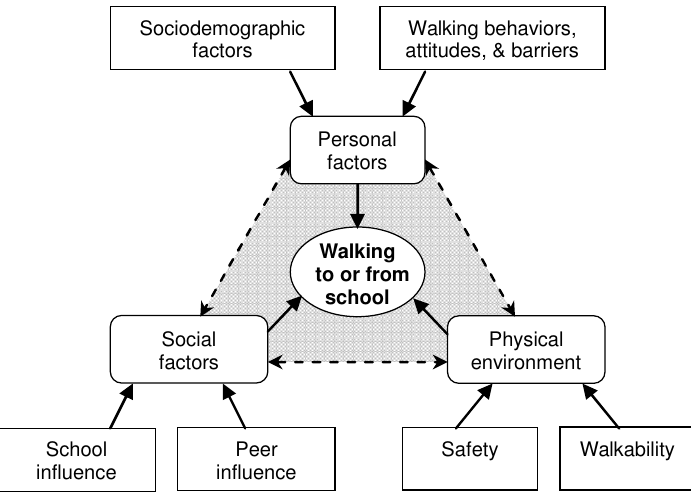
FIGURE 1. Conceptual framework on children’s walking to or from school